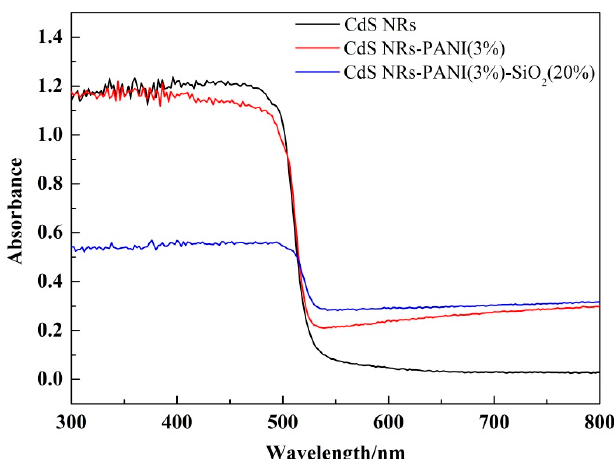
Figure 7. UV-visible diffuse reflectance spectra of CdS NRs, CdS NRs-PANI (3%), and CdS NRs-PANI (3%)-SiO 2 (20%).